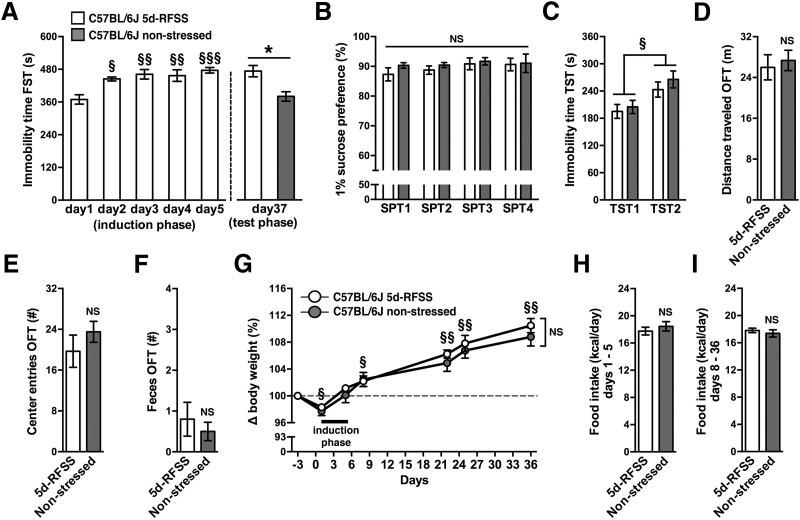
Effects of 5d-RFSS on depressive-like behavior in C57BL/6J mice. A, Immobility time of 5d-RFSS C57BL/6J mice during the induction phase (days 1–5) forced-swim tests (FST; main effect of time, F(4,36) = 8.68, p = 0.00005; post hoc test, §p = 0.006, §§p = 0.001, §§§p = 0.0002 vs day 1), and of 5d-RFSS and nonstressed control mice during the test phase (day 37; t(1,18) = 3.44, *p = 0.003 vs nonstressed mice). B, Two-bottle SPTs before 5d-RFSS (SPT1) and after 5d-RFSS (SPT2 to SPT4). C, TST immobility time before 5d-RFSS (TST1) and after 5d-RFSS (TST2; main effect of time, F(1,18) = 9.14, p = 0.007; post hoc test, §p = 0.007 vs TST1). D–F, Distance traveled (t(1,18) = 0.43, p = 0.67; D), number of center zone entries (t(1,18) = 1.01, p = 0.33; E), and number of feces produced during the OFT (t(1,18) = 0.63, p = 0.53; F). G, Change in body weight (%) from day −3 to 36 (main effect of time, F(6,108) = 90.48, p < 0.00001; post hoc test, §p = 0.02, §§p = 0.0001 vs day −3). H, I, Food intake during induction phase (days 1–5; t(1,17) = 0.77, p = 0.45; H) and during days 8–36 (t(1,18) = 0.71, p = 0.49; I). NS, Not significant. n = 10/group for all experiments.